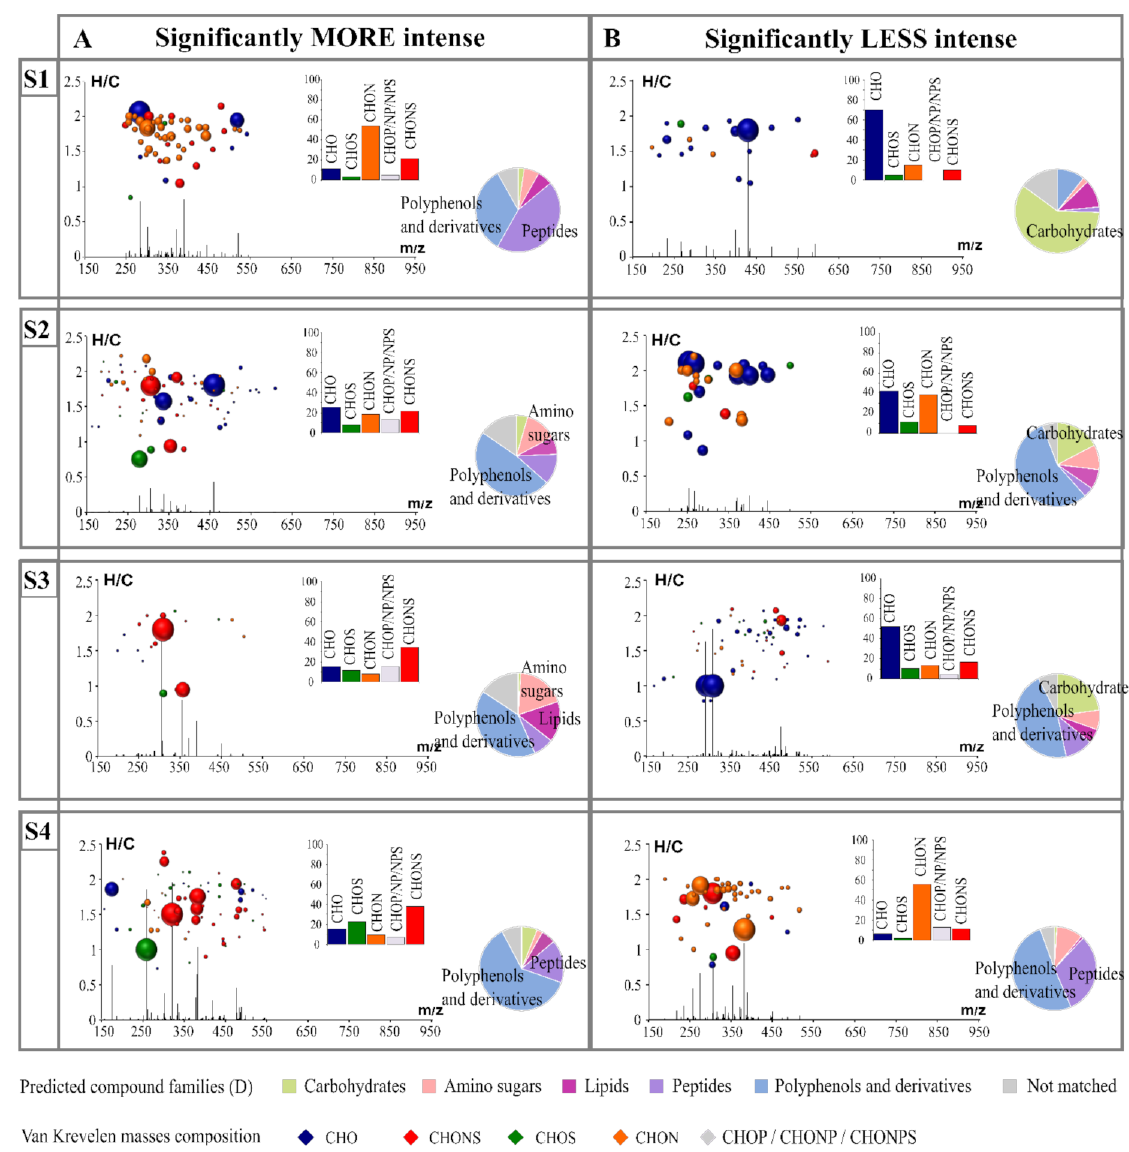
Figure 2. H/C vs. m/z van Krevelen diagrams combined with intensity vs. m/z diagrams coupled to histogram proportions of the elemental formula compositions exhibit specific strain markers significantly less ( B ) and more ( A ) intense in each fermentation. Bubble sizes indicate relative intensities of corresponding masses. Color code: CHO, blue; CHON, orange; CHONS, red; CHOS, green. The pie chart represents the distribution of these markers by hypothetical families of common wine